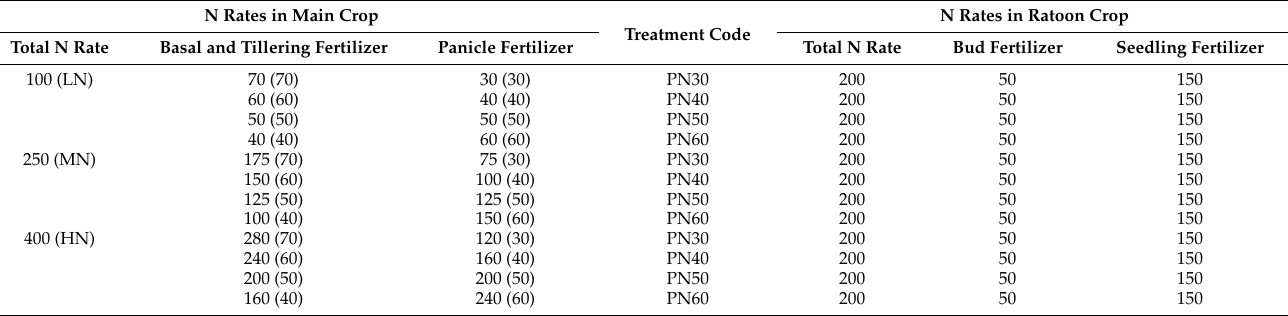
Table 1. Nitrogen application rates (kg N ha − 1 ) in the main and ratoon